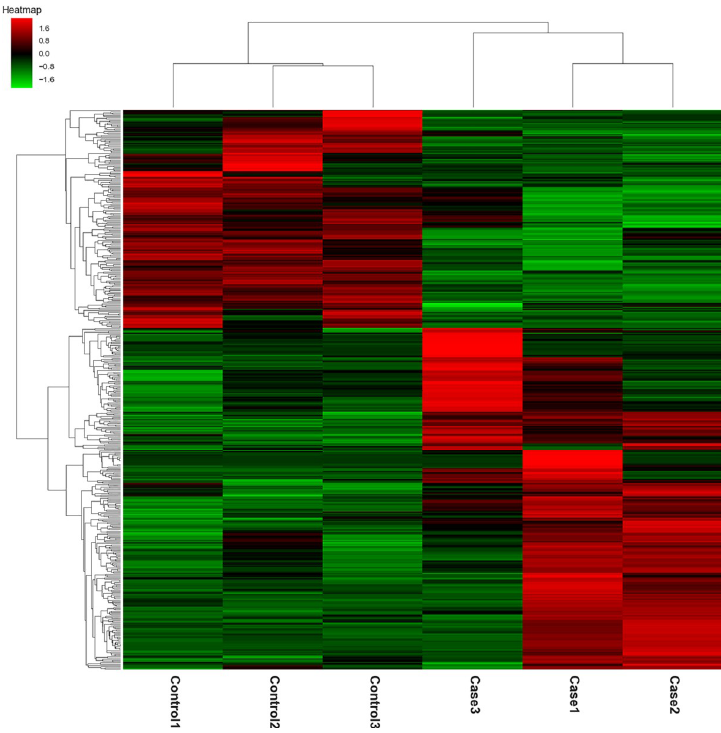
Fig 4. Hierarchical clustering analysis of the 453 DE mRNAs in the CI-AKI and control group ( P < 0.05). Each group includes 3 duplicates. Colors from green to red represent the gene expression abundance from poor to rich.